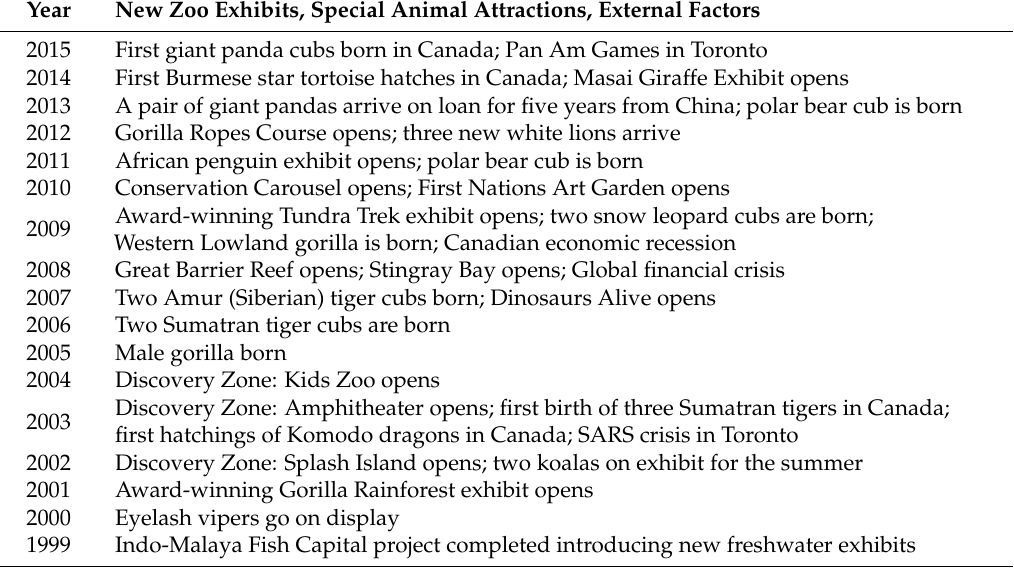
Table 3. Annual history of new zoo exhibits, special animal attractions, and major external factors